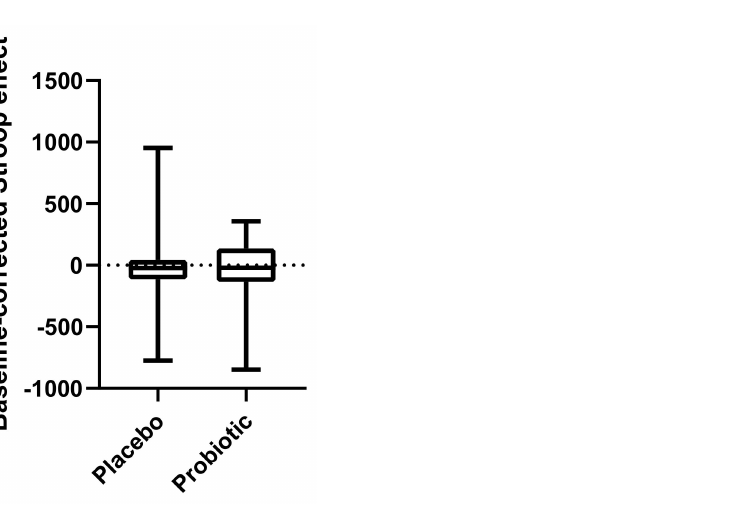
Figure 5. Cognitive performance measured as Stroop effect (baseline-corrected, after-before interven- tion). Line presents median, box presents 25th and 75th percentile, and whiskers present minimum to maximum. Wilcoxon matched-pairs signed rank test, n =